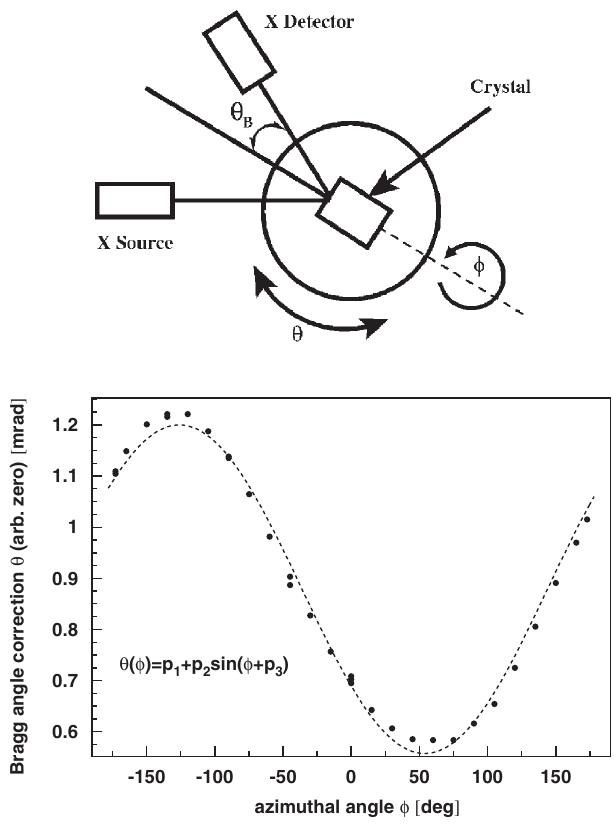
FIG. 11. Schematic setup (top) and measurements of the Bragg peak adjustment angle (cid:3) as a function of the azimuthal rotation angle (cid:9) (bottom) for the annular stage alignment of the quarter wave plate crystal with x rays.